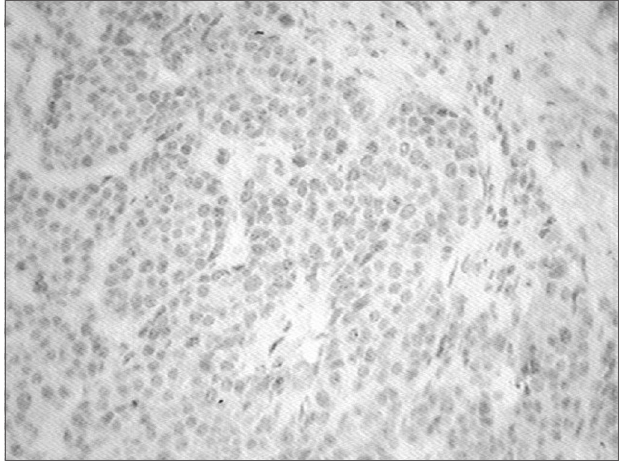
Figure 1. Immunohistochemistry-p53 - Cells dyed in brown show a positive